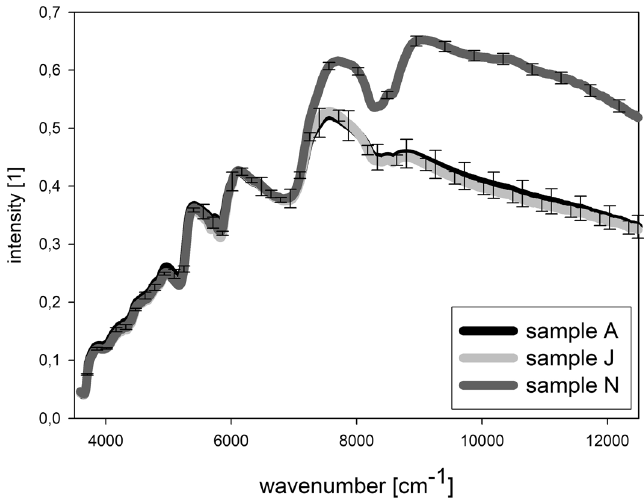
Figure 1. Representative NIR spectra (mean of 5) of three samples before evaluation.